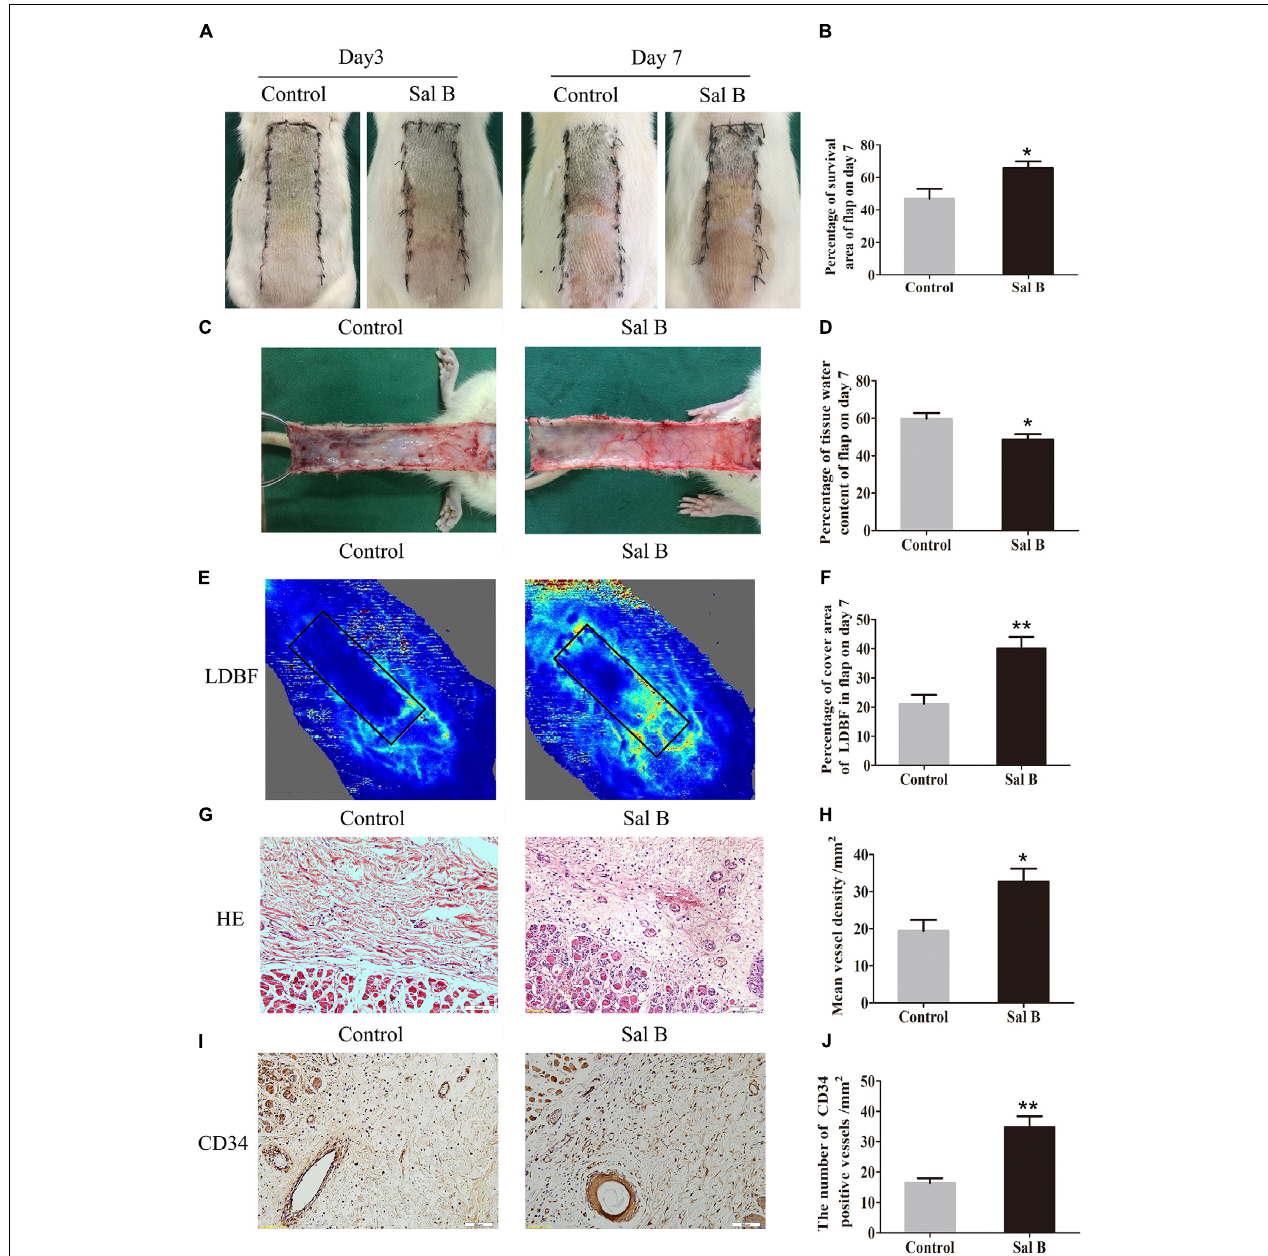
FIGURE 1 | Effects of Sal B on random skin flaps vitality. (A) Digital photographs of flap survival of the Control and Sal B group on post-operative days 3 and 7 (scale bar: 2 cm). (B) Histogram of percentages of flap survival area on post-operative day 7. (C) Digital photographs of the inner side of skin flaps in each group on post-operative day 7 showing tissue edema (scale bar: 2 cm). (D) Histogram of percentages of tissue water content of skin flaps. (E) LDBF imaging showing vascular flow and blood supply in skin flaps on post-operative day 7 (scale bar: 2 cm). (F) Histogram of percentages of area of blood supply. (G) H&E staining of microvessels in area II of skin flaps (original magnification, 200 × ; scale bar: 50 µ m). (H) Histogram of MVDs by H&E staining. (I) IHC for CD34 in area II of skin flaps (original magnification: 200 × ; scale bar: 50 µ m). (J) Histogram of CD34-positive vessel densities. ∗ p < 0.05 and ∗∗ p < 0.01 vs. the control group. Data are means ± SEM ( n = 6 per